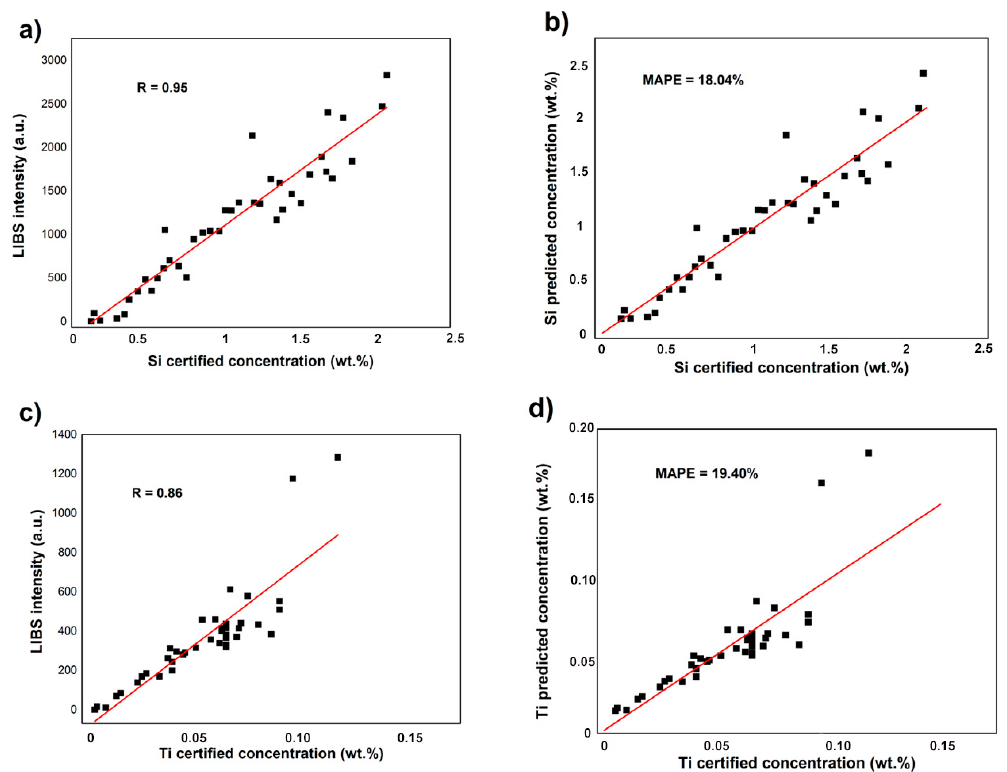
Figure 5. Univariate calibration ( a , c ) and validation ( b , d ) curves for Si and Ti versus certified X-ray fluorescence (XRF) concentrations.